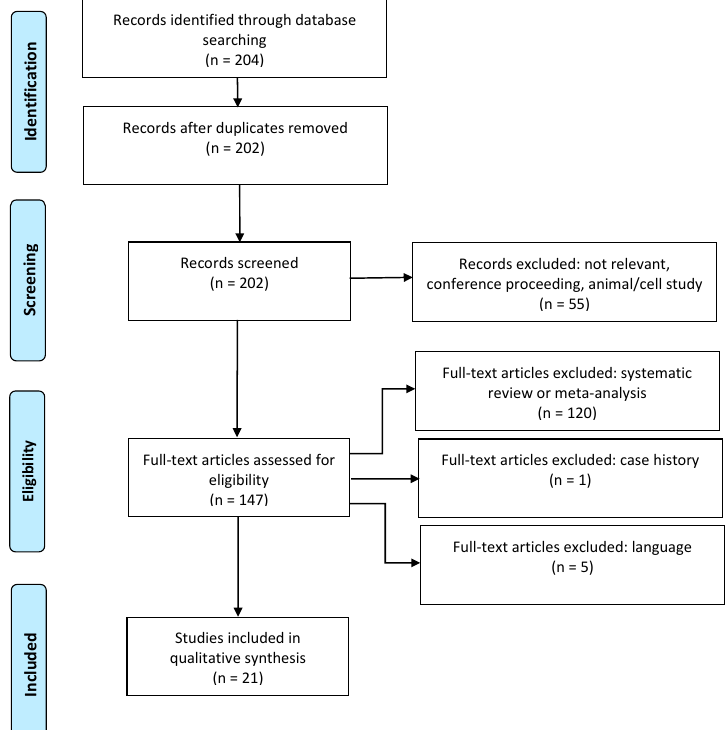
Figure 1. Preferred reporting for systematic review and meta-analysis (PRISMA) flow chart.